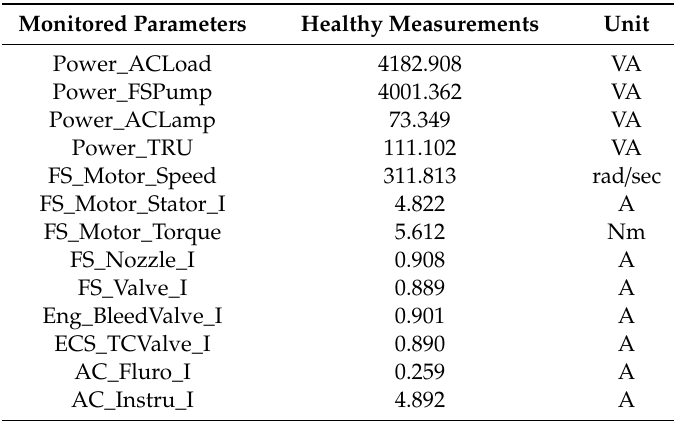
Table 1. Measured values during the Healthy